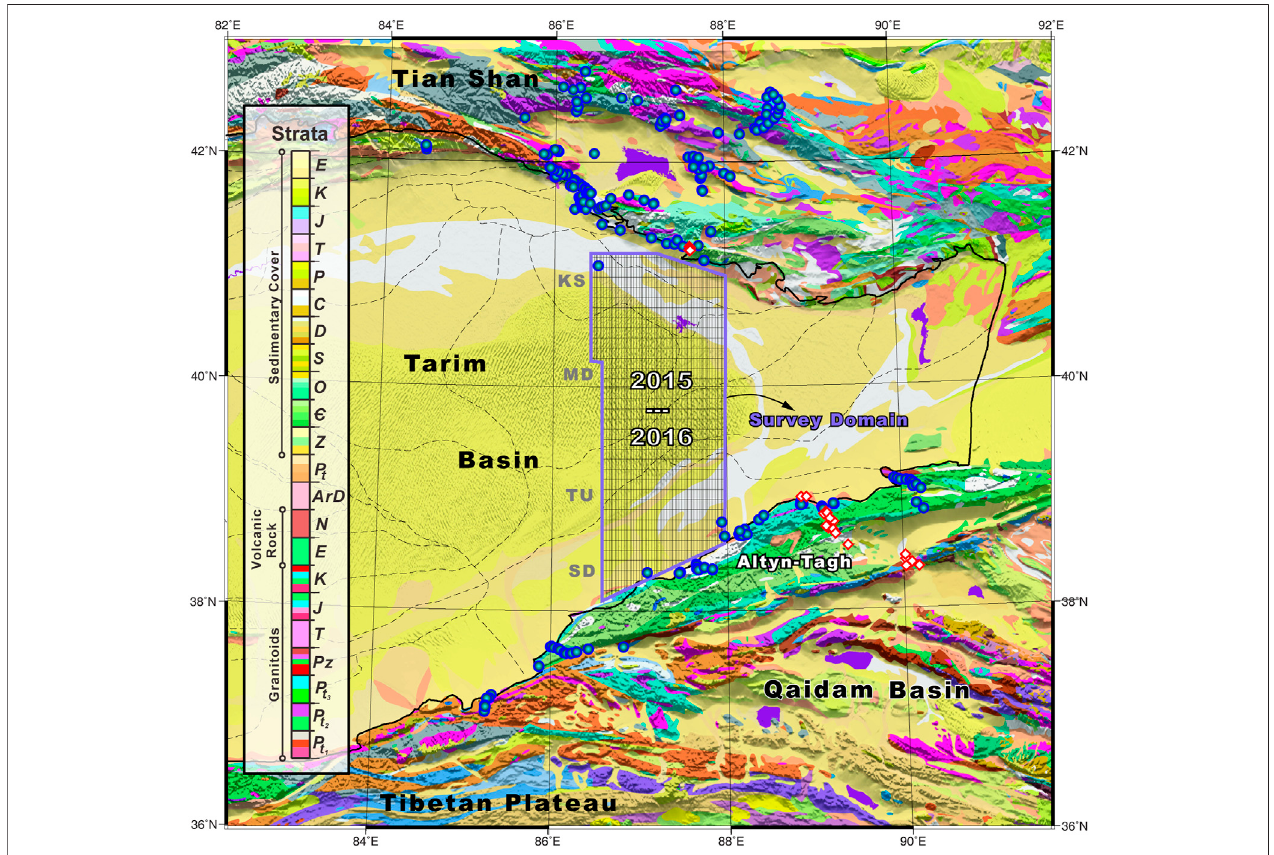
FIGURE 2 | Simpli fi ed geological map of the Eastern Tarim Basin and its tectonic units (XJBGMR (Bureau of Geology and Mineral Resources of Xinjiang Province), 1993). The blue polygon is the region of aeromagnetic data acquired in this study, the lines inside the blue polygon are survey fl ight paths. The blue circles and red diamonds indicate the locations for measuring the magnetic susceptibility of sampling rocks by us and our coworkers, respectively. The measured magnetic measurements are compiled in Table 1 and Table 2 . Abbreviations are as follows: KS: Kongquehe Slope, MD: Mangal Depression, TU: Tadong Uplift, SD: Southeastern Depression.